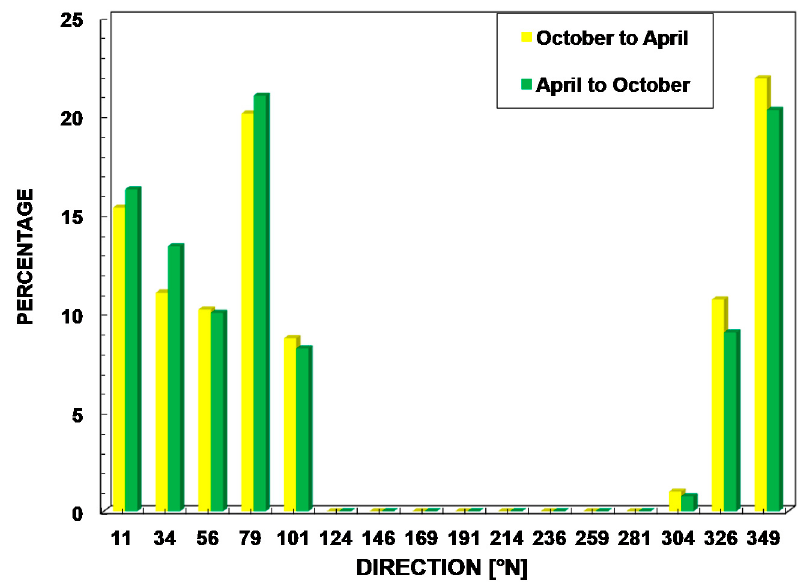
Figure 3. Histogram of the wave directions. Onshore directed angles are removed.